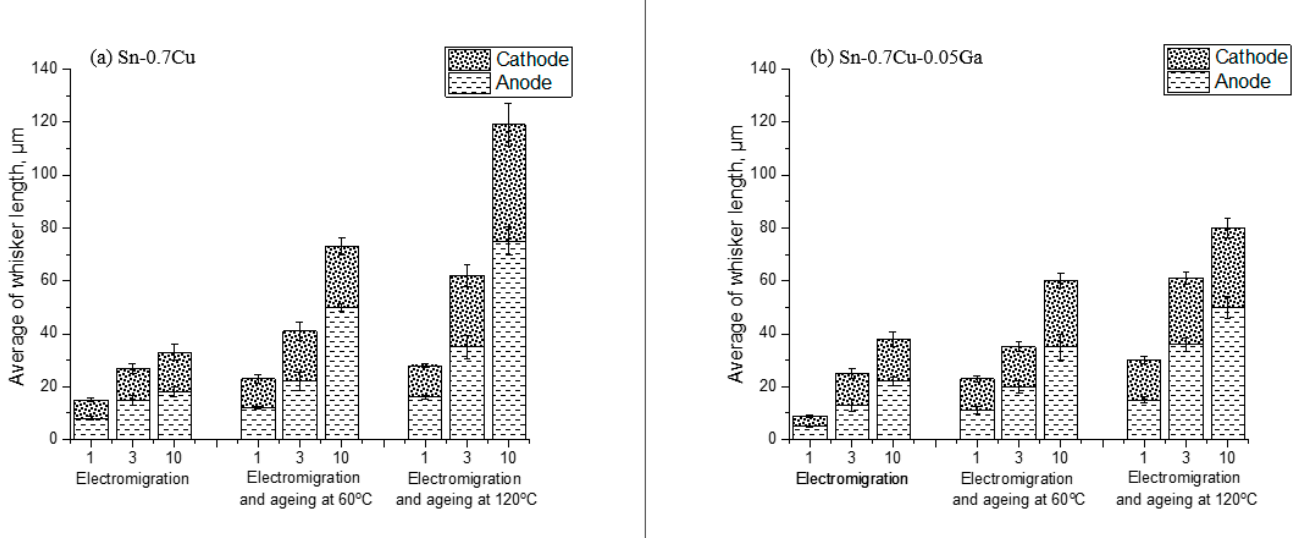
Figure 11. The average length of Sn whiskers after electromigration with and without thermal ageing at 60 °C and 120 °C, at anode and cathode side, after 1, 3, and 10 days: ( a ) Sn–0.7Cu; ( b ) Sn–0.7Cu–0.05Ga.